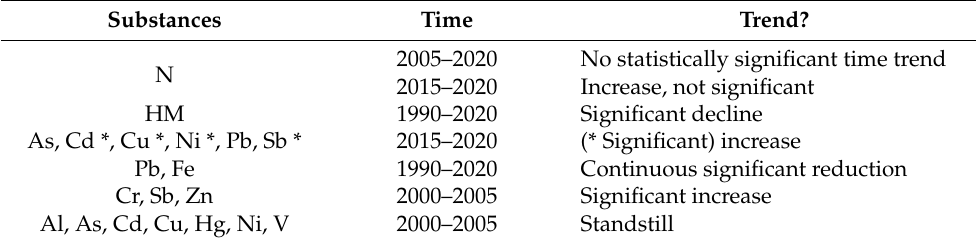
Table 10. Trends in the accumulation of metal and nitrogen deposition in moss samples collected from 1990 to 2020 across